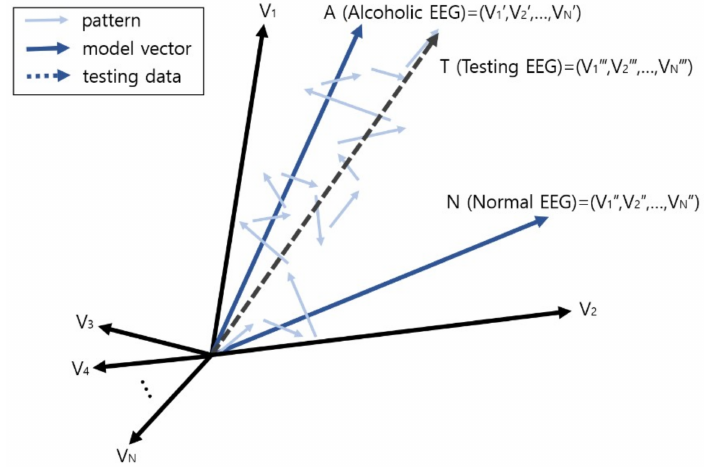
Figure 7. Prediction or diagnosis of brain disease through vector